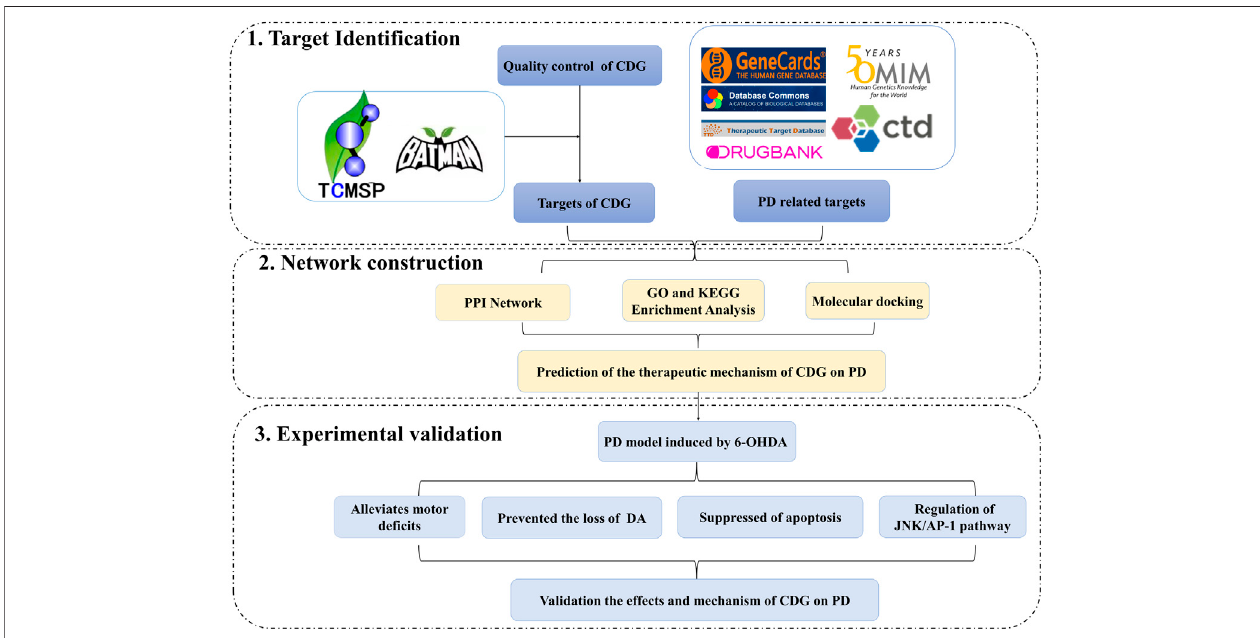
FIGURE 10 | A fl owchart of the research design for investing the therapeutic mechanisms of Compound Dihuang Granule (CDG) on PD by integrating target identi fi cation, network analysis, and experimental validation.